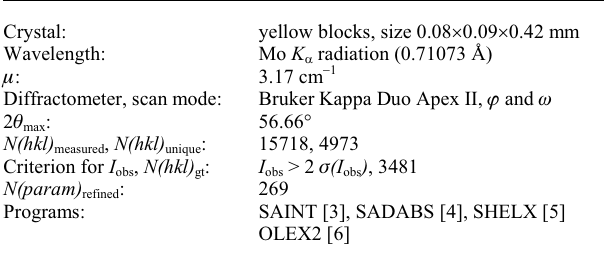
Table 1. Data collection and handling.